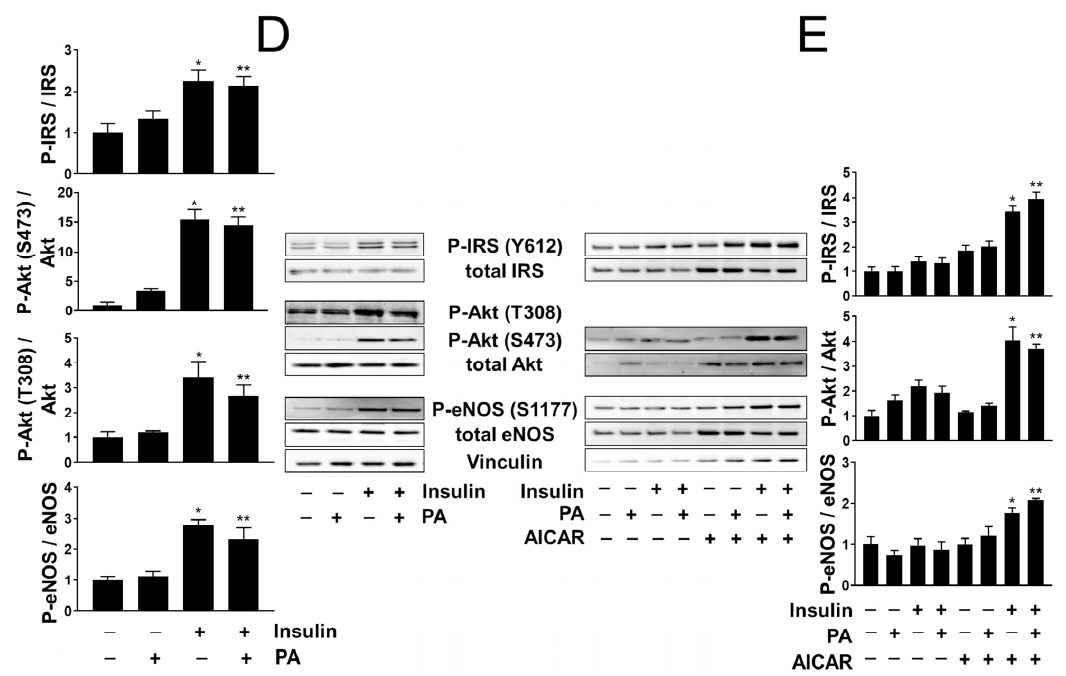
Figure 3. Effects of AICAR and palmitate on AMPK, inflammatory and insulin signaling. Cells were treated with 0.75 mM PA if not indicated otherwise, 100 nM insulin, and 1 mM AICAR. Shown are representative images of at least three independent experiments. Bar graphs represent quantitative analyses of the corresponding Western blots. Data are presented as the mean ± SEM. Mann–Whitney U -test was applied to analyze the differences. ( A ) AICAR upregulates, in PA- and insulin-independent manner, phosphorylation of ACC at Ser-79 that reports on AMPK activity. *, p < 0.05 vs. untreated control; **, p < 0.05 vs. PA; #, p < 0.05 vs. insulin; ##, p < 0.05 vs. PA + insulin, n = 5. ( B ) Activating phosphorylation of inflammatory IKK and JNK1/2 kinases in HUVEC treated with indicated PA concentrations for 5 days, n = 2. ( C ) Scheme of insulin signaling in endothelial cells showing the principal components and their phosphorylation sites assessed by Western blots in d–e. ( D ) Insulin signaling in cells treated with 0.75 mM PA for 5 days. *, p < 0.05 vs. untreated control; **, p < 0.05 vs. PA, n = 4. ( E ) Insulin signaling in cells treated with 0.75 mM PA in the presence or absence of 1 mM AICAR for 7 days as indicated. *, p < 0.05 vs. untreated control; **, p < 0.05 vs. PA, n =